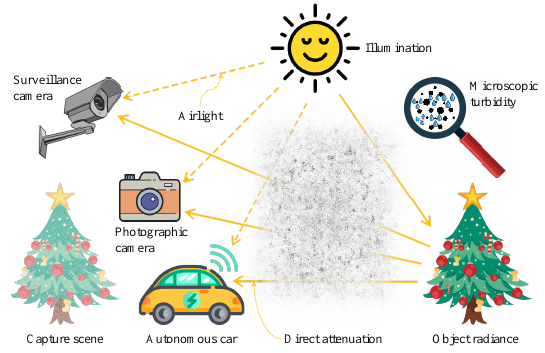
Figure 1. Optical hazy image